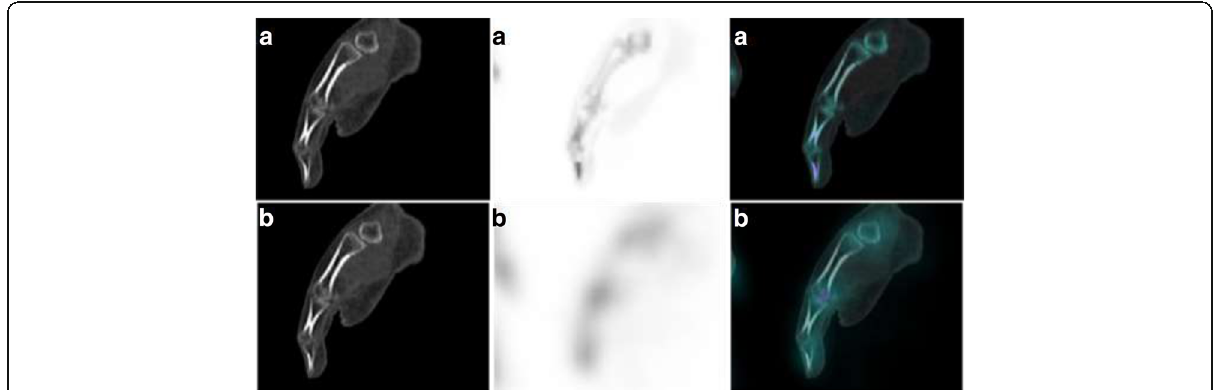
Fig. 2 Example of false positive of xSPECT Bone®. This SPECT/CT was performed in order to explore a focal distal thumb pain persisting after a traumatism occurred several months ago. A moderate uptake involving only the last phalange of the thumb, higher than the other phalangeal uptakes, is observed on the xB image ( a ), matched with the focal pain and suggesting an osteitis. However, there is no pathological uptake on the F3D image ( b ). The MRI performed after SPECT/CT was normal and ruled out the osteitis. A conversion disorder was